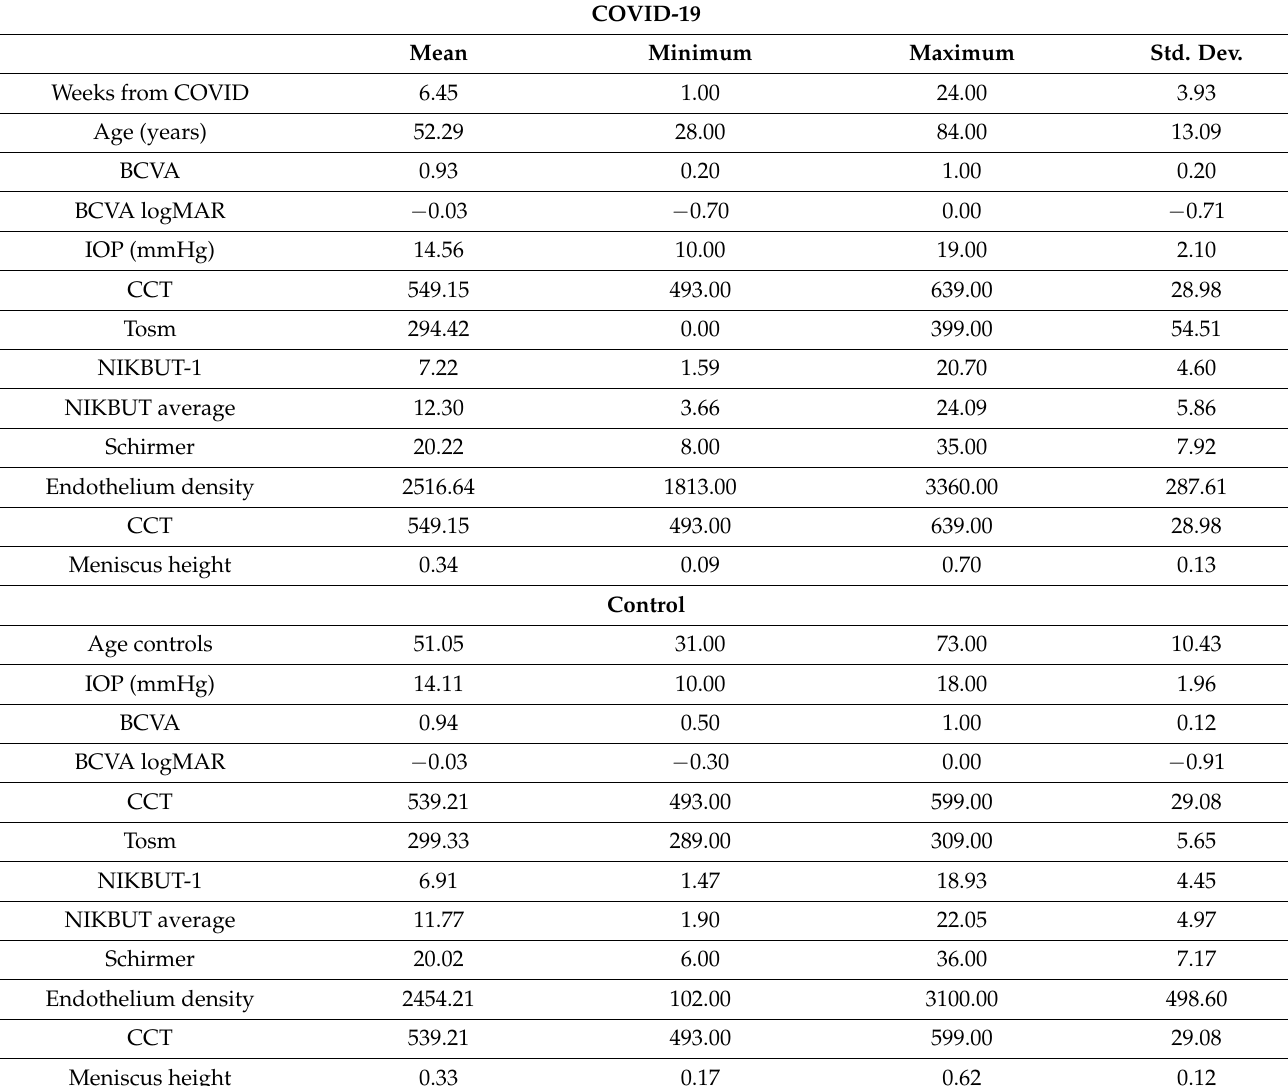
Table 1. Clinical and demographic characteristics of enrolled